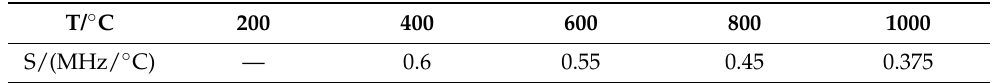
Table 1. 200~1000 ◦ C relative sensitivity S .